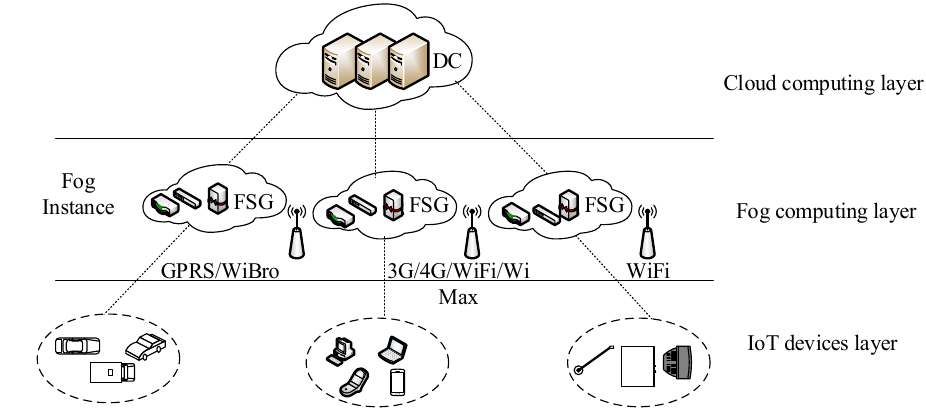
Figure 1. Fog computing architecture.